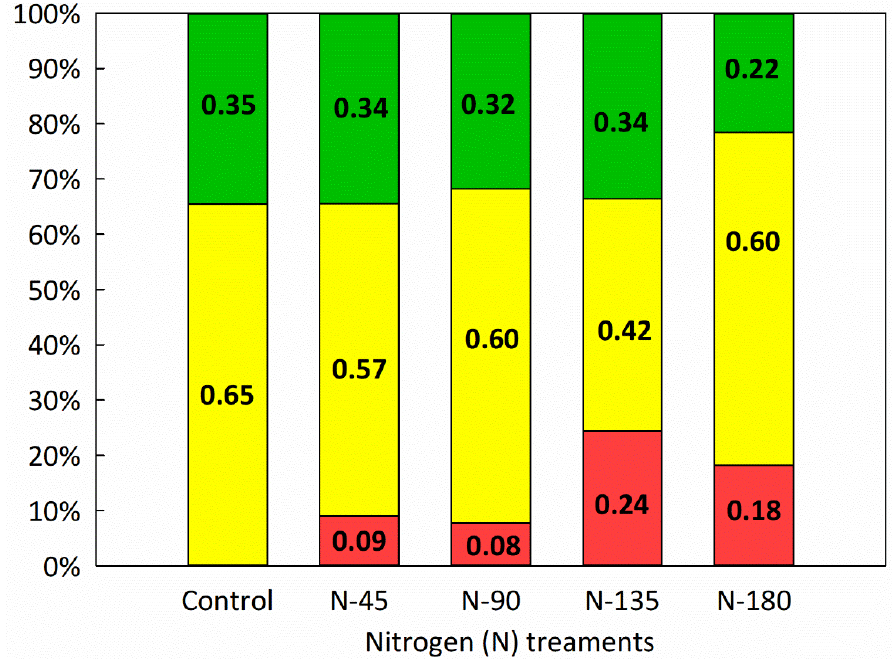
Figure 5. Stoplight chart for profit probabilities of less than $100 ha −1 and greater than $1,000 ha −1 for FM 958. The probabilities of achieving favorable, unfavorable, and questionable outcomes are represented by green, red, and yellow color, respectively.